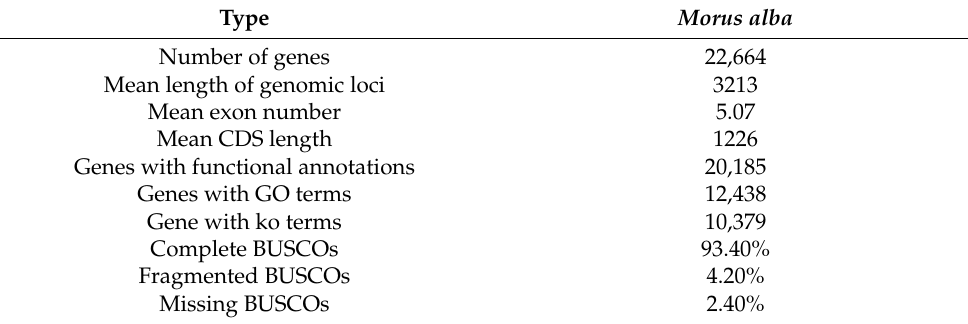
Table 2. Assessment for gene structure re-annotation of Morus alba .